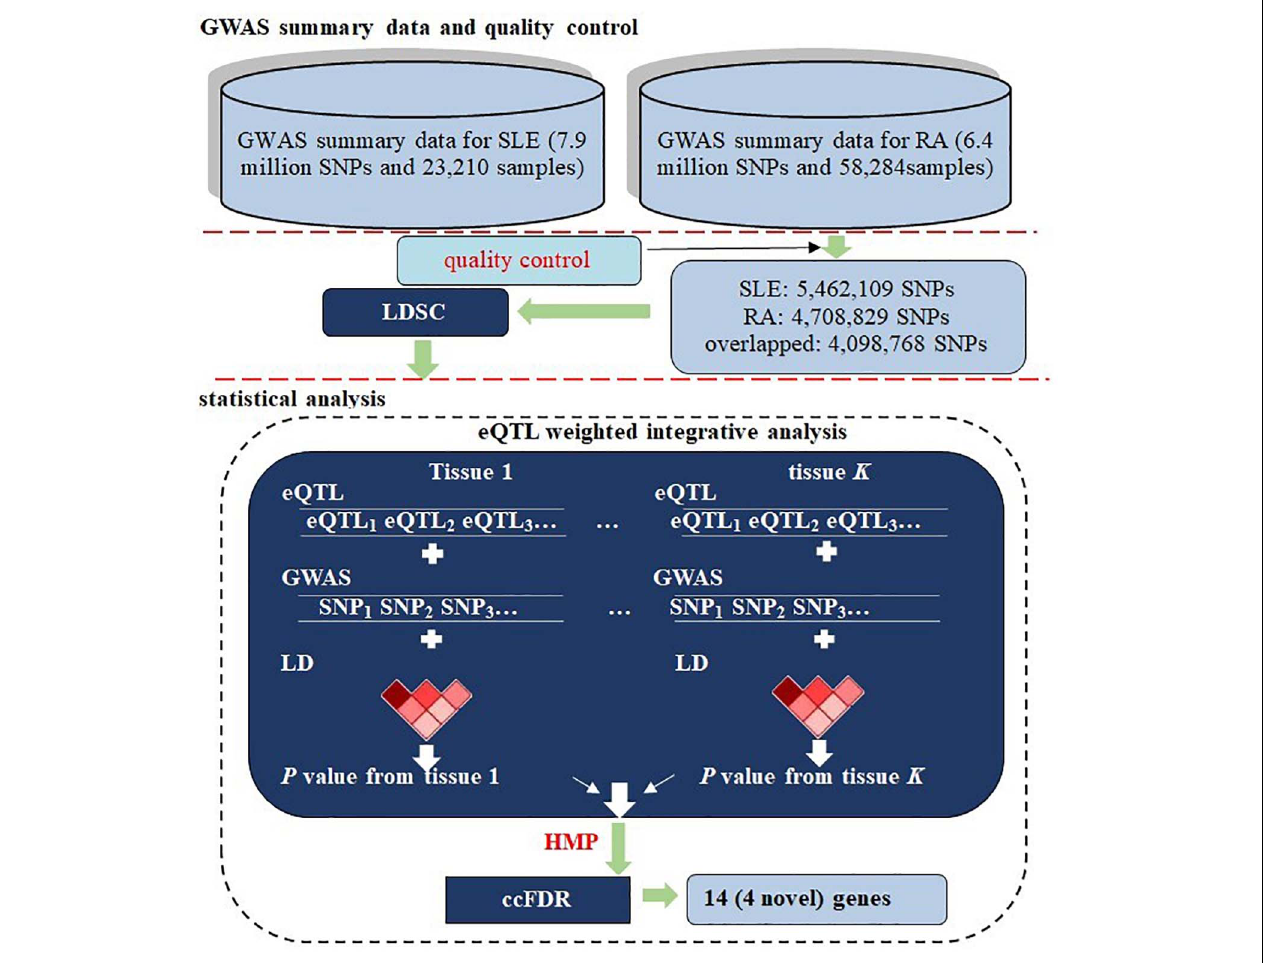
FIGURE 1 | Flowchart of data preparation and analysis for RA and SLE. First, two sets of summary statistics were included for the two diseases; a series of quality control procedures were implemented and the genetic correlation between RA and SLE was evaluated using LDSC. Next, a multiple-tissue eQTL weighted integrative analysis was performed to aggregate association signals at the SNP level into the gene level, following by the HMP combination across tissues. Finally, cFDR was carried out to identify associated genes with pleiotropic effects. In the analysis, the LD was estimated with genotypes of the 1000 Genomes